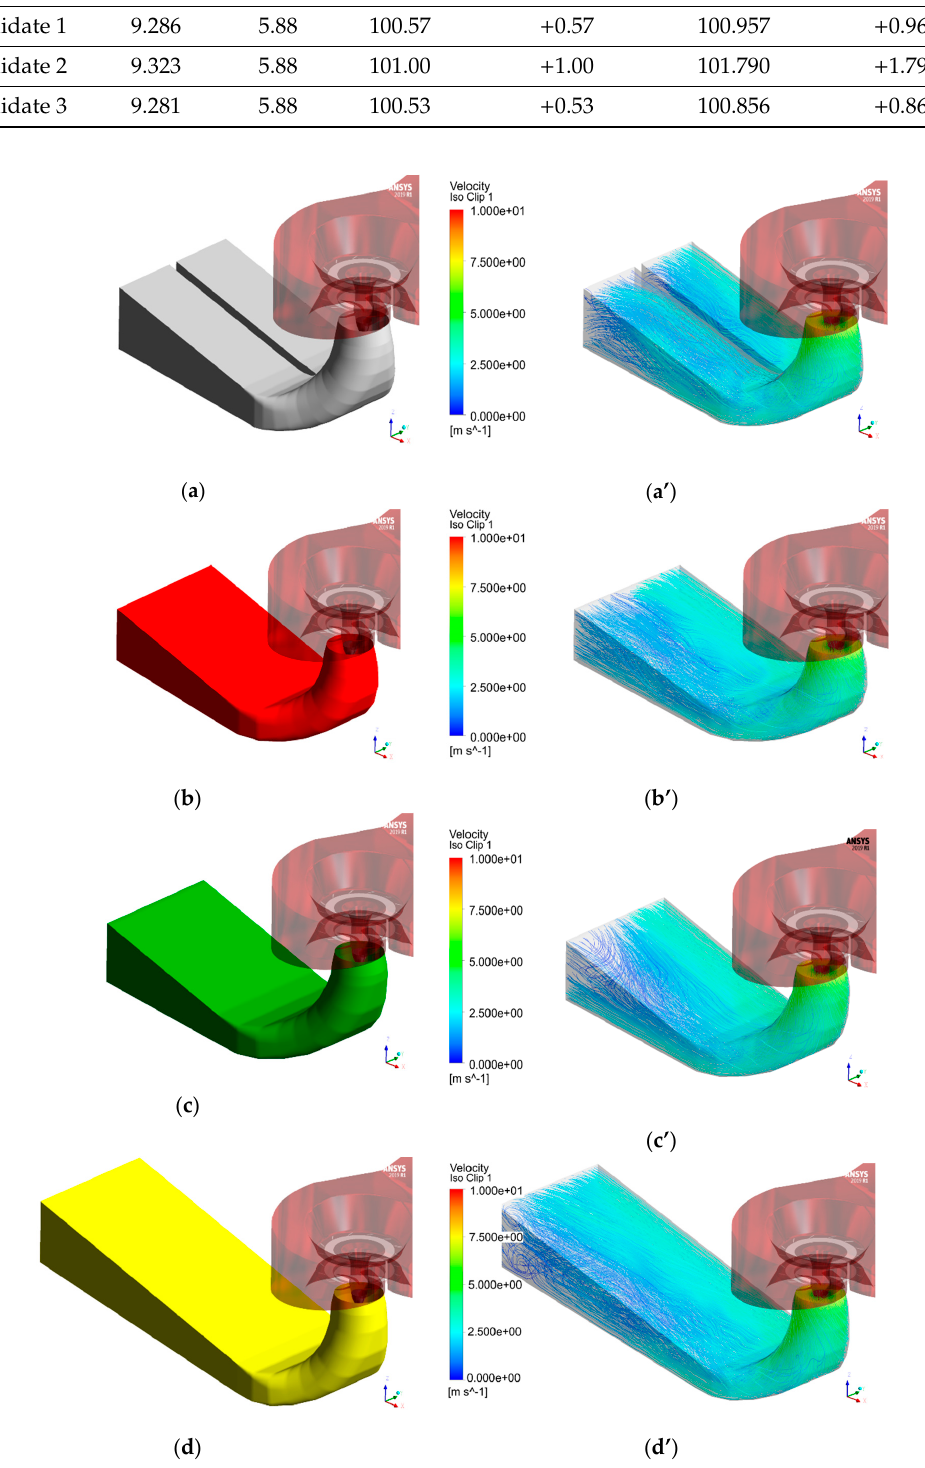
Figure 11. Comparison of geometries (left column), and streamlines colored by velocity (right column): ( a,a’ ) Baseline; ( b,b’ ) Candidate 1; ( c,c’ ) Candidate 2; ( d,d’ ) Candidate 3.